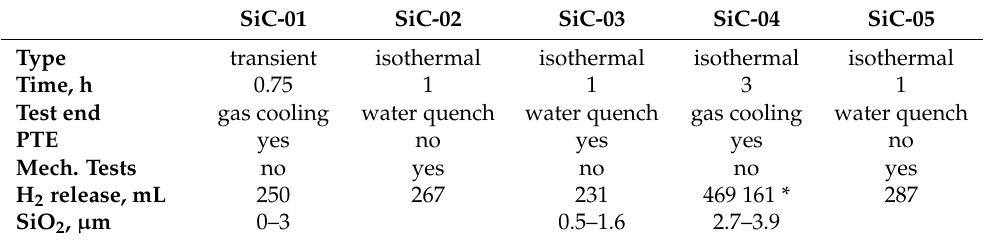
Table 1. Test characteristics, post-test examinations conducted, and selected